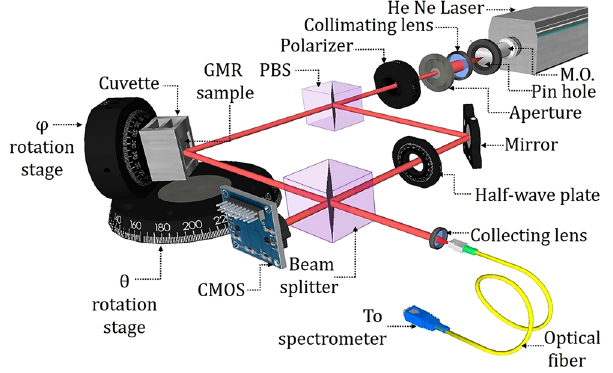
Figure 3. MZI setup. Schematic of the experimental setup of Mach Zehnder Interferometer to measure the phase shift of the GMR signal (drawn using Google